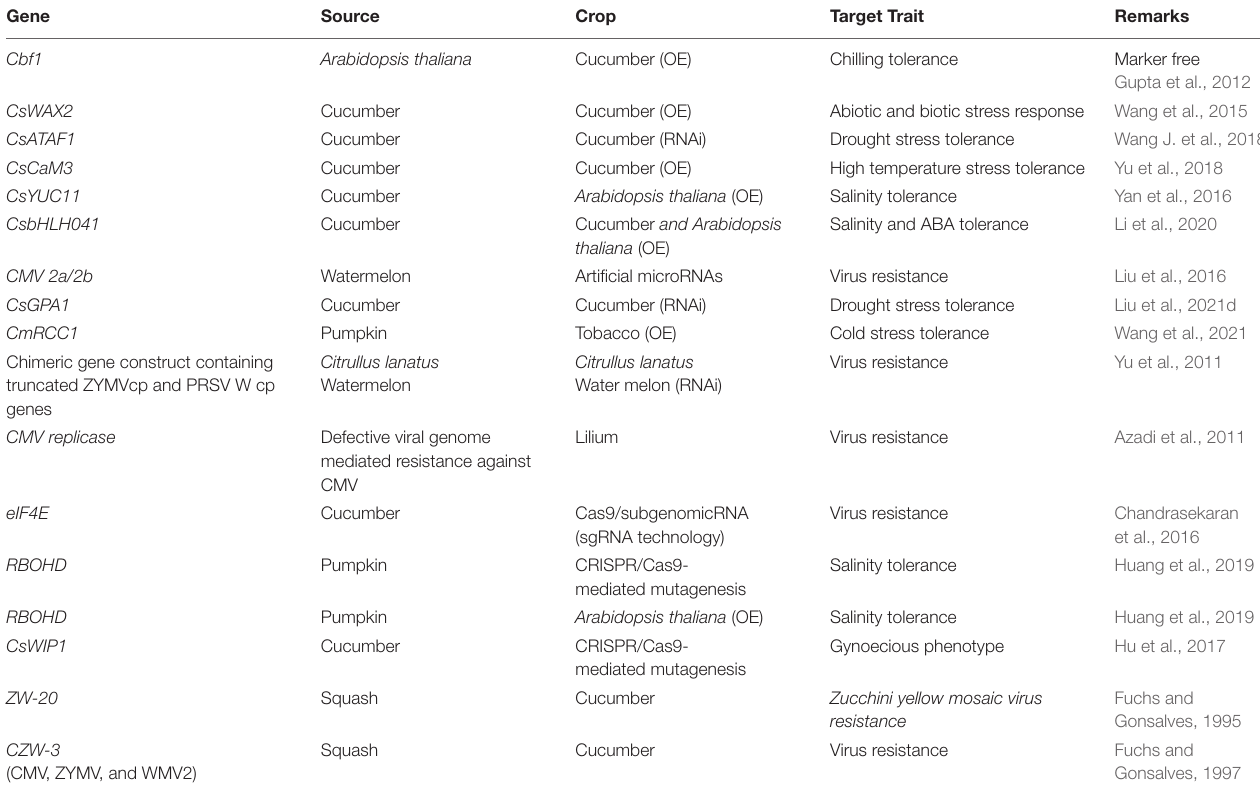
TABLE 4 | Trait-gene discovery and functional or translational characterization in cucurbits.